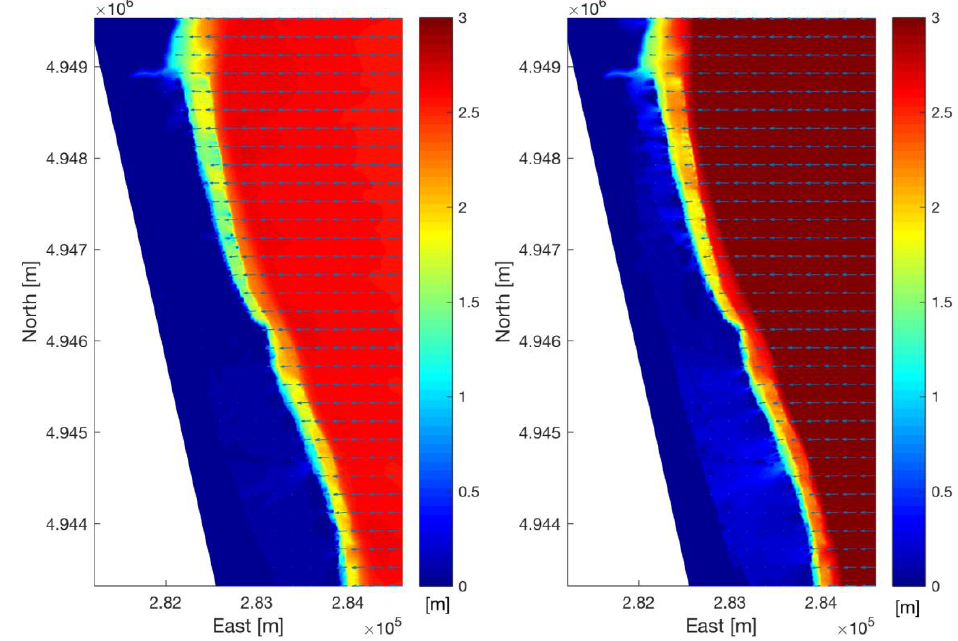
Figure 7. Sirocco events. Distribution of significant wave height and mean wave direction vectors for SCE—S1 ( left panel ) and SCE—S25 ( right panel ) runs, respectively.